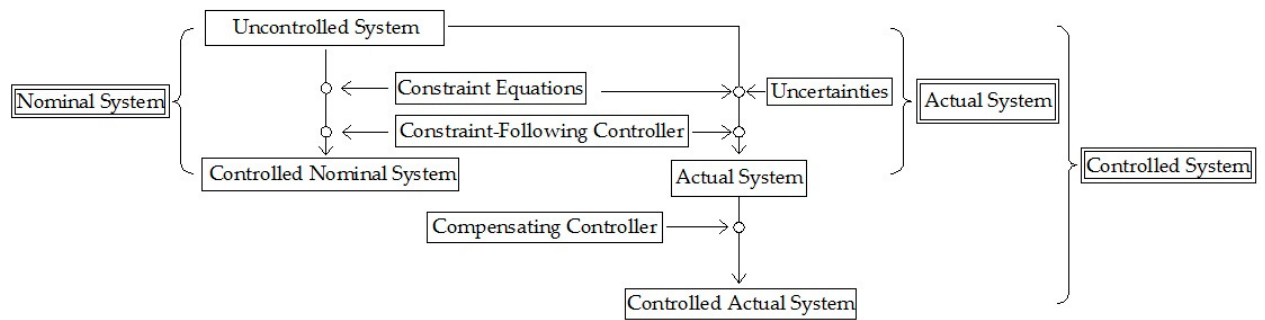
Figure 3. The flowchart for the proposed method.